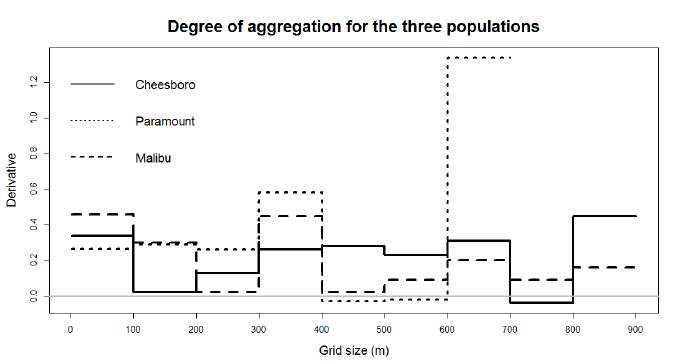
Figure 8. Degree of aggregation for the three populations obtained by calculating the instantaneous rate of change (the first derivative) every 100 m. Values near zero ( y -axis) indicate a random distribution linearly measured ( x -axis) from the bottom-left corner of the respective population extent. Values greater than zero denote clustering and less than zero a dispersed